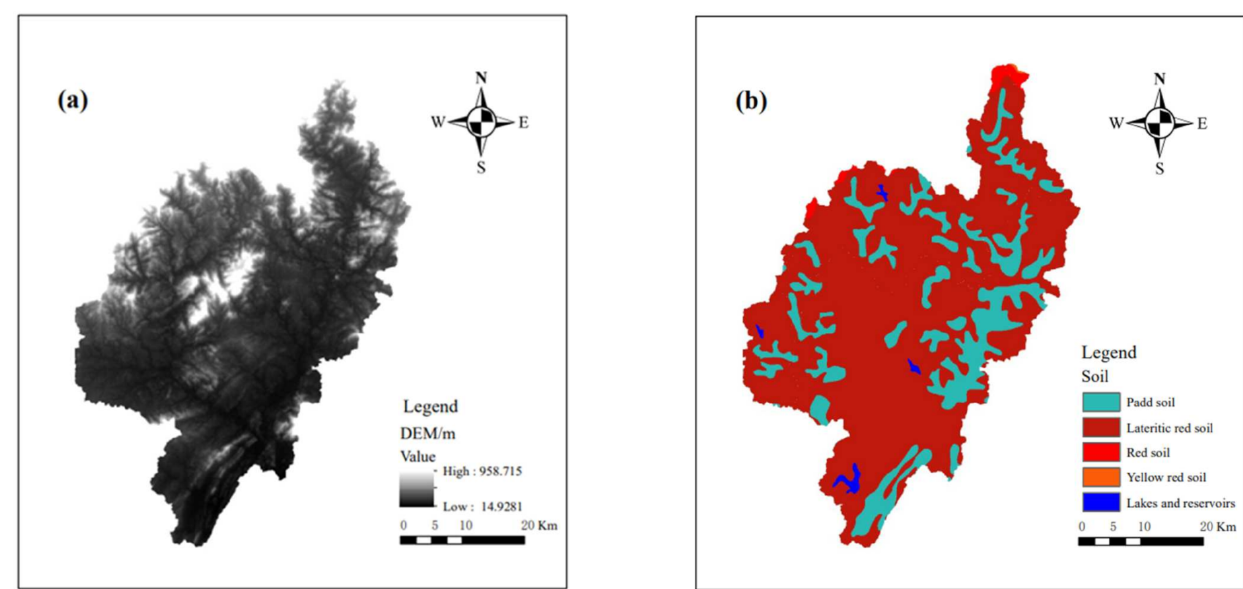
Figure 2. Digital elevation data ( a ), and soil type data ( b ).